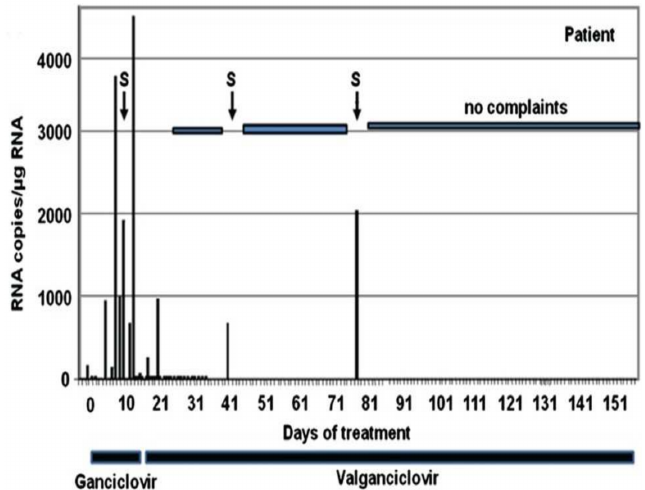
Figure 8. Example of a chromosomally integrated human herpesvirus 6B (ciHHV6B)-positive female patient with persisting high cardiac and systemic virus loads and cardiac involvement treated with antiviral gancyclovir. HHV6 RNA levels are shown as viral copy numbers per 1 µ g of RNA. A symptomatic increase of mRNA (S) was noted between days 13 and 21 when i.v. ganciclovir was changed to oral administration. During short symptomatic phases (S) at days 41 and 75, again mild increases of mRNA were detected